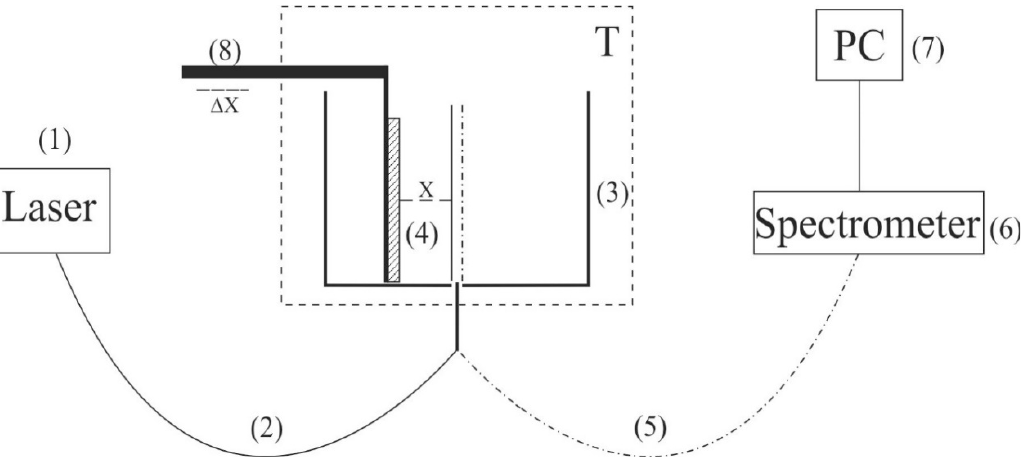
Figure 1. A schematic of the experimental setup: (1) continuous wave laser diode, (2, 5) multimode optical fibers, (3) cell with liquid sample, (4) Nafion plate, (6) spectrometer, (7) computer, (8) stage with horizontal micrometric feed for aligning Nafion plates with respect to the optical axis, and (T) is thermostat.